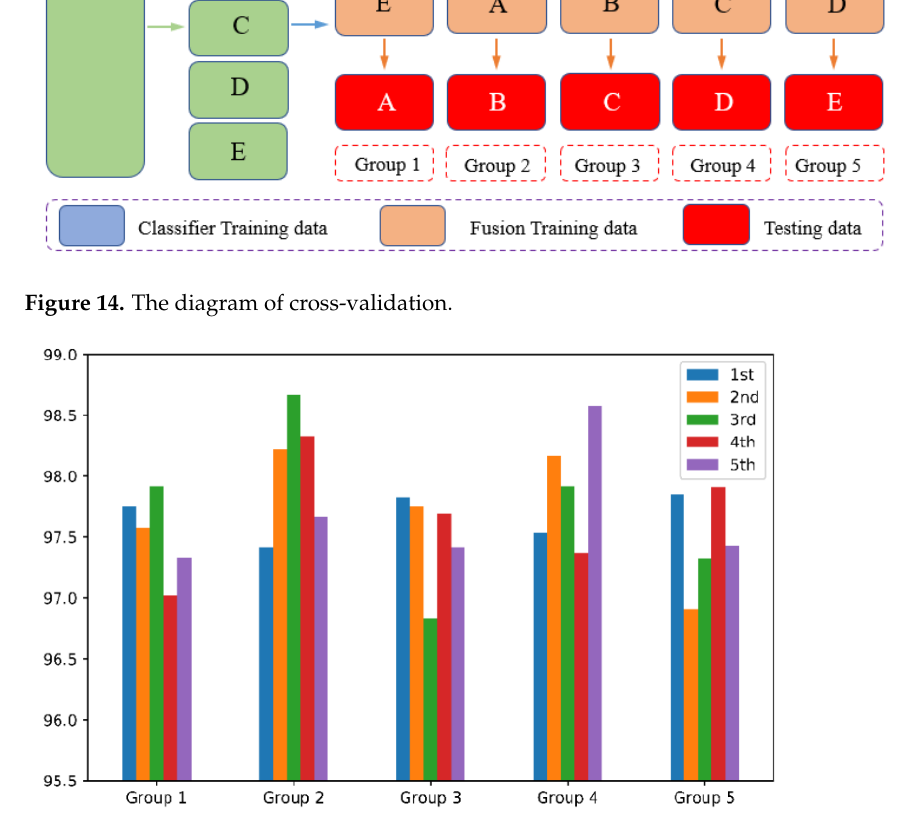
Figure 15. Bar chart of accuracy (%) with five groups cross-validation.